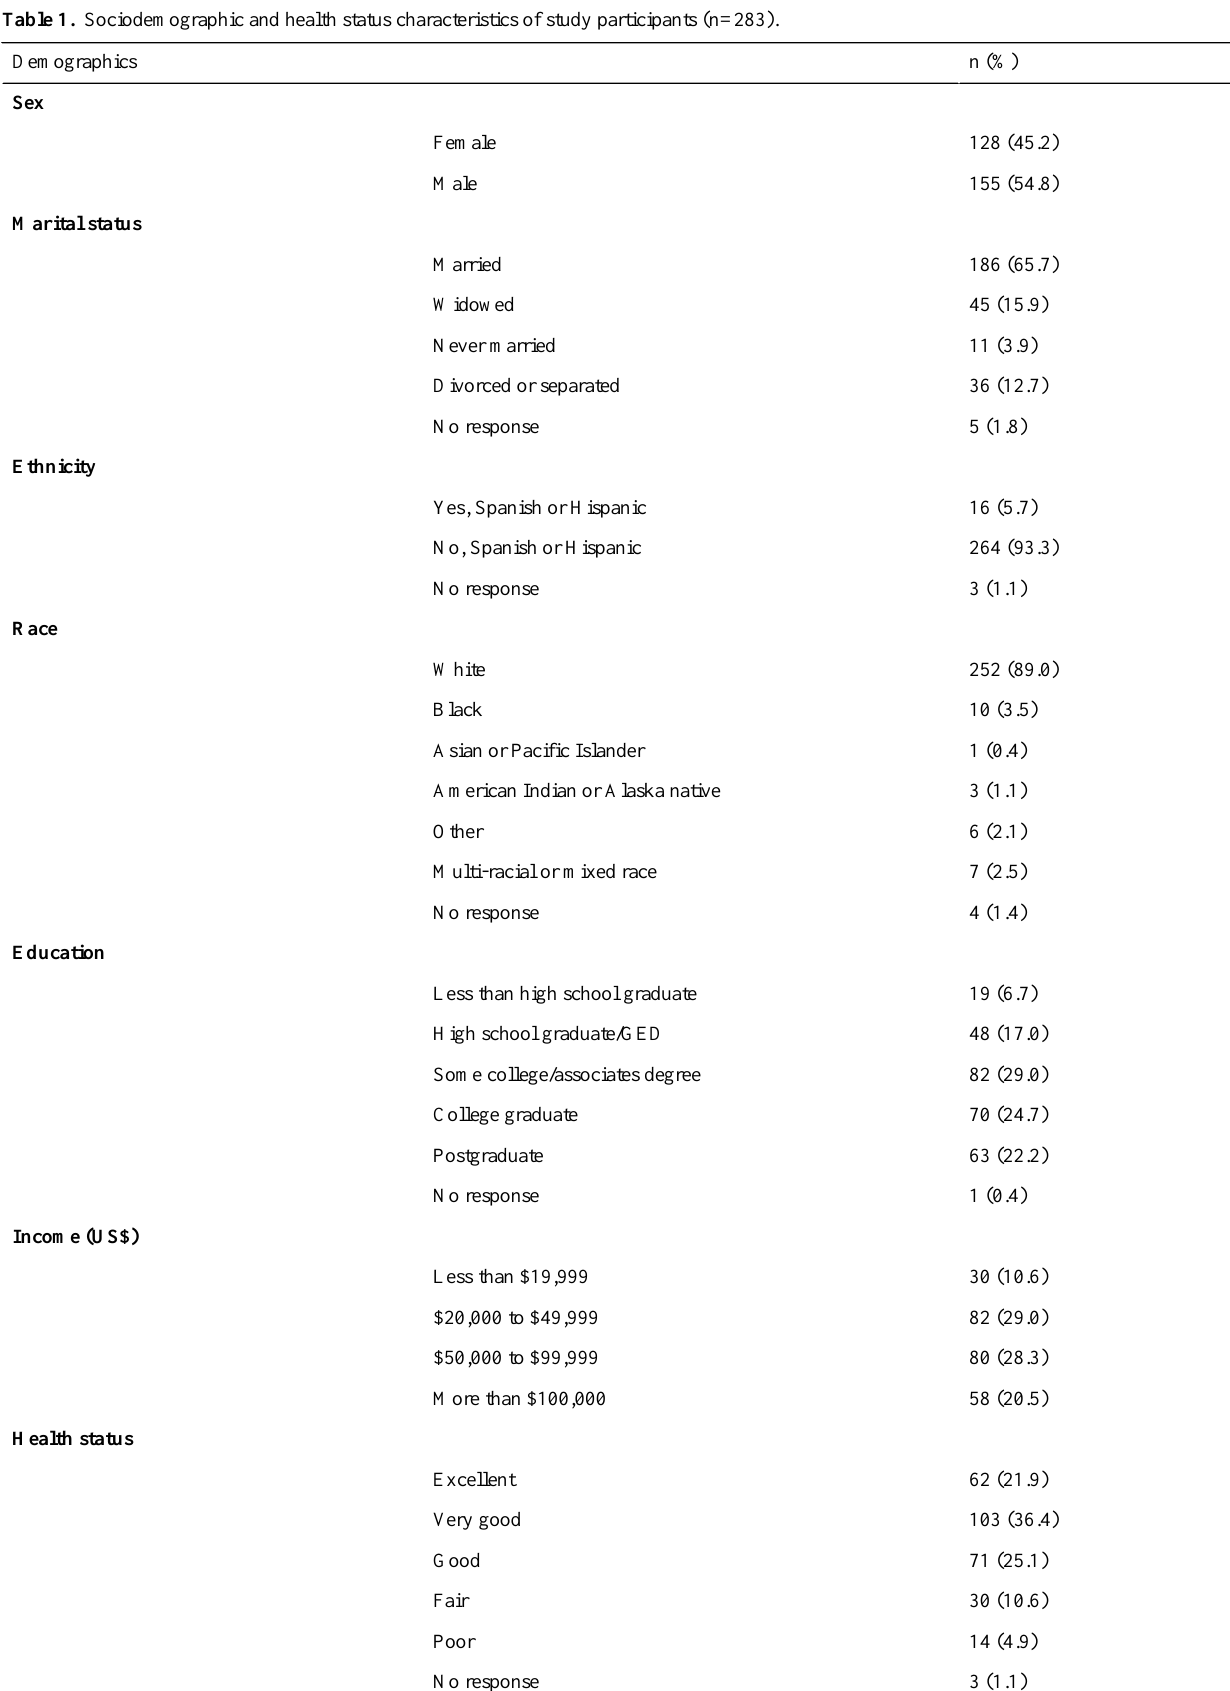
Table 1. Sociodemographic and health status characteristics of study participants (n =